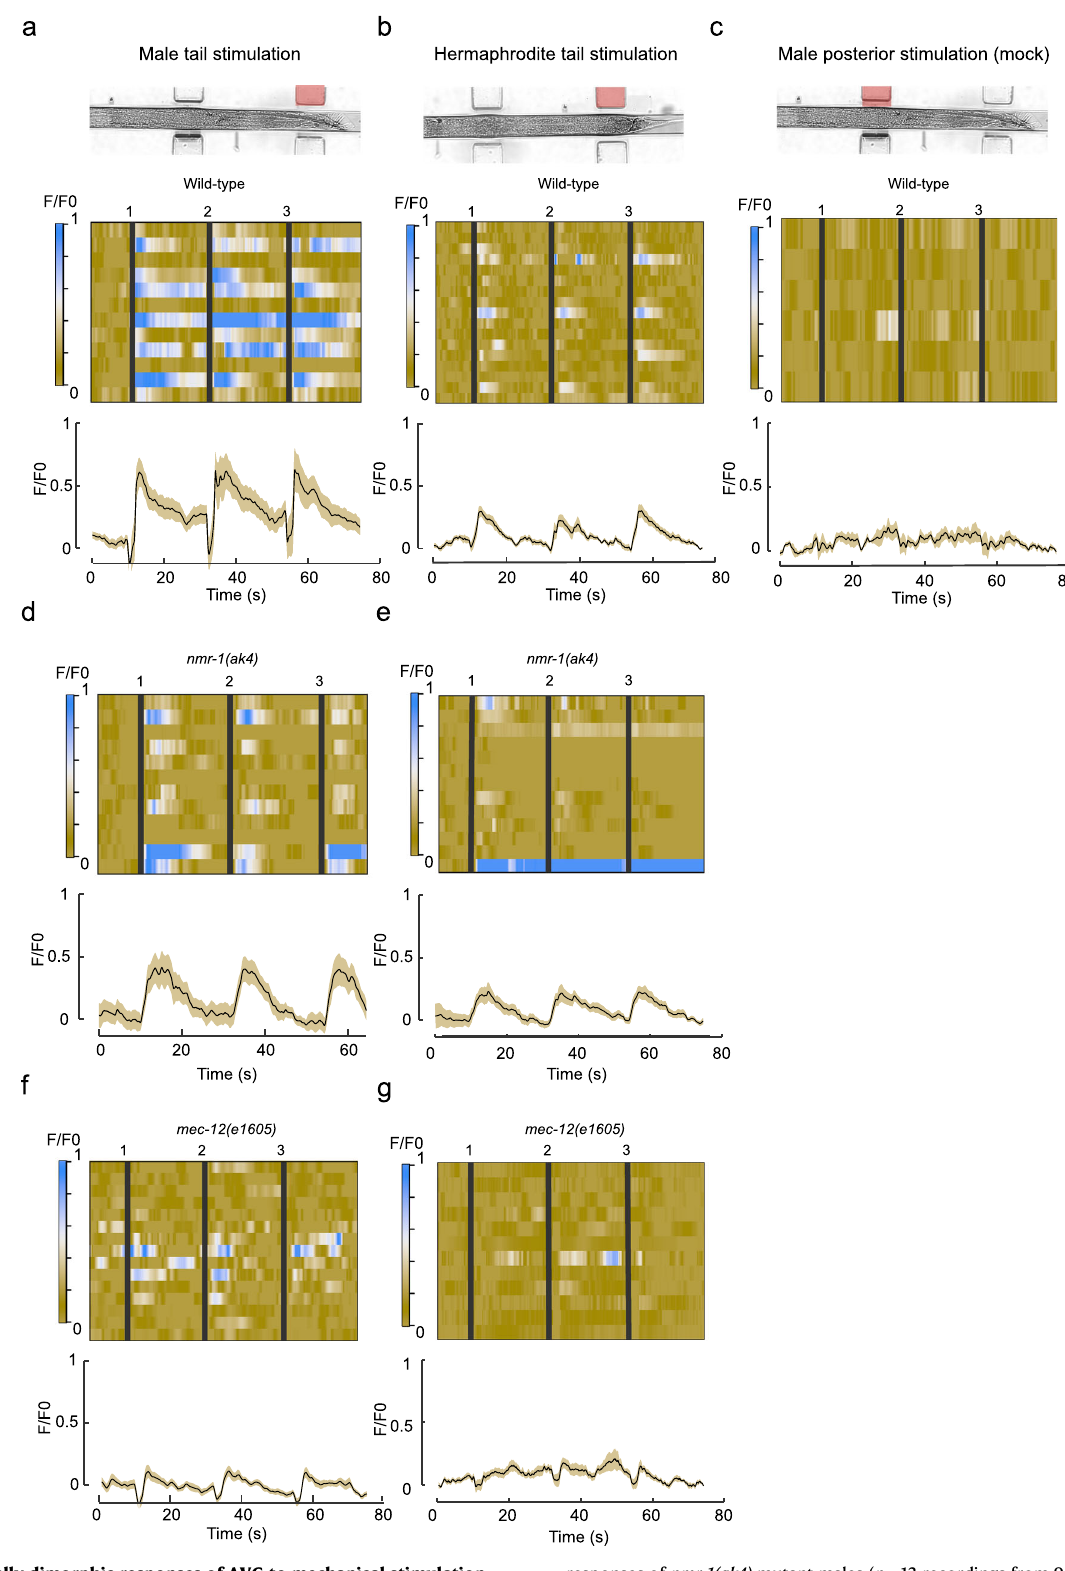
responses of nmr-1(ak4) mutant males ( n =13 recordings from 9 animals) ( d ) and hermaphrodites ( n =14 recordings from 8 animals) ( e ) to three consecutive tail mechanical stimulations. f , g AVG GCaMP6s calcium responses of mec-12(e1605) mutant males ( n =28 recordings form 16 animals) ( f ) and hermaphrodites ( n =12 recordings from 10 animals) ( g ) to three consecutive tail mechanical stimulations. Each 3.5bar stimulus was applied for two seconds (see Methods ). Full statistical analysis can be found in Supplementary Fig.